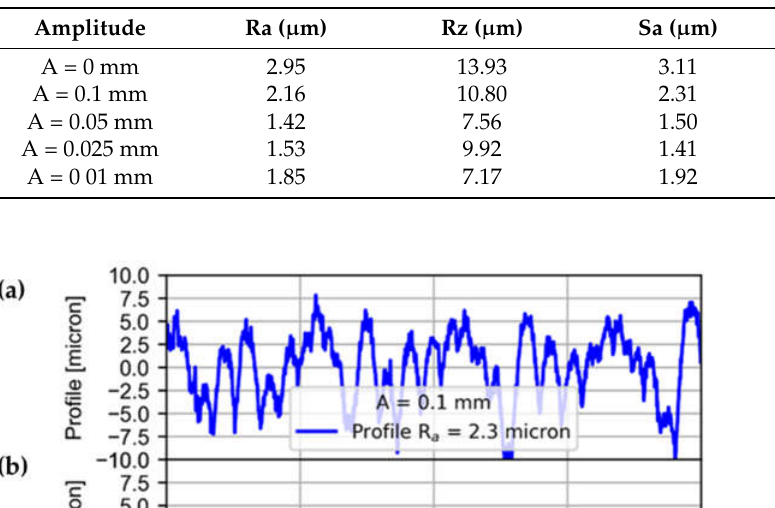
Table 5. Summary of roughness results at different vibration amplitudes with f = 4 Hz.